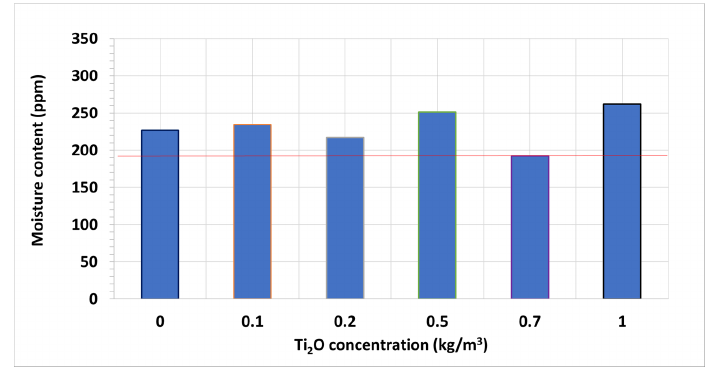
Figure 5. Mean moisture content of tested TiO 2 nanofluid samples.